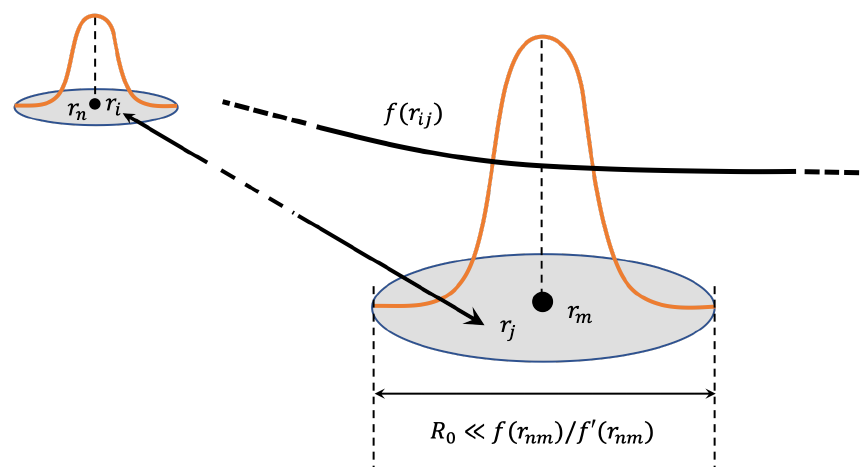
Figure 1: Origin of the effective charge approximation. Due to the smooth- ( j ) one can approximately rewrite ness of f ( r ) and the localized nature of ψ 0 m (cid:80) ) ψ 0 ( j ) as f ( r ) q 0 = f ( r ) (cid:80) ψ 0 ( j ) . f ( r ij im im j j m m m